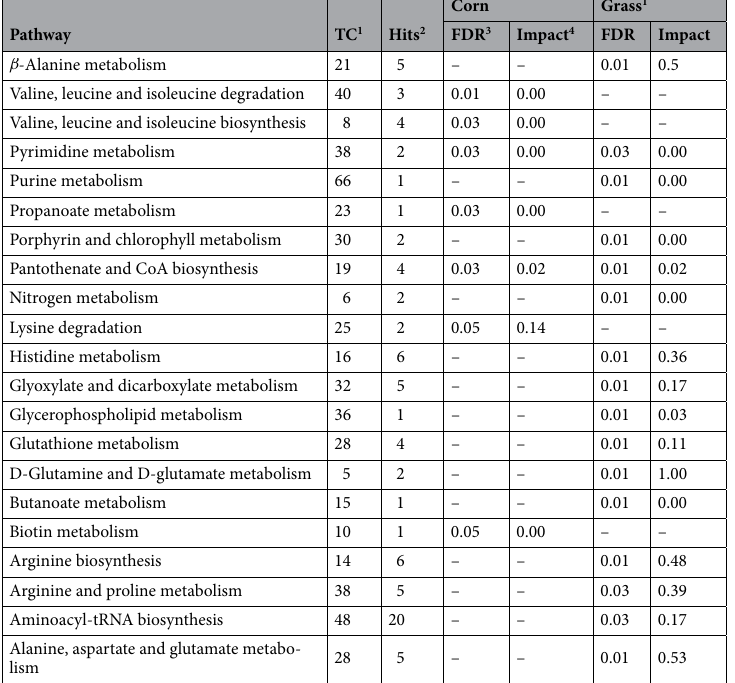
Table 4. Identified metabolic pathways associated with RFI differences in young bulls fed either corn- or grass-silage diets. 1: Total number of metabolites theoretically considered by the KEGG database for identify metabolic pathways. 2: Metabolites effectively quantified in the current study (Figs. 3, 4). 3: FDR > 0.05 is depicted by “–”. 4: Topological analysis of impact of the current metabolic